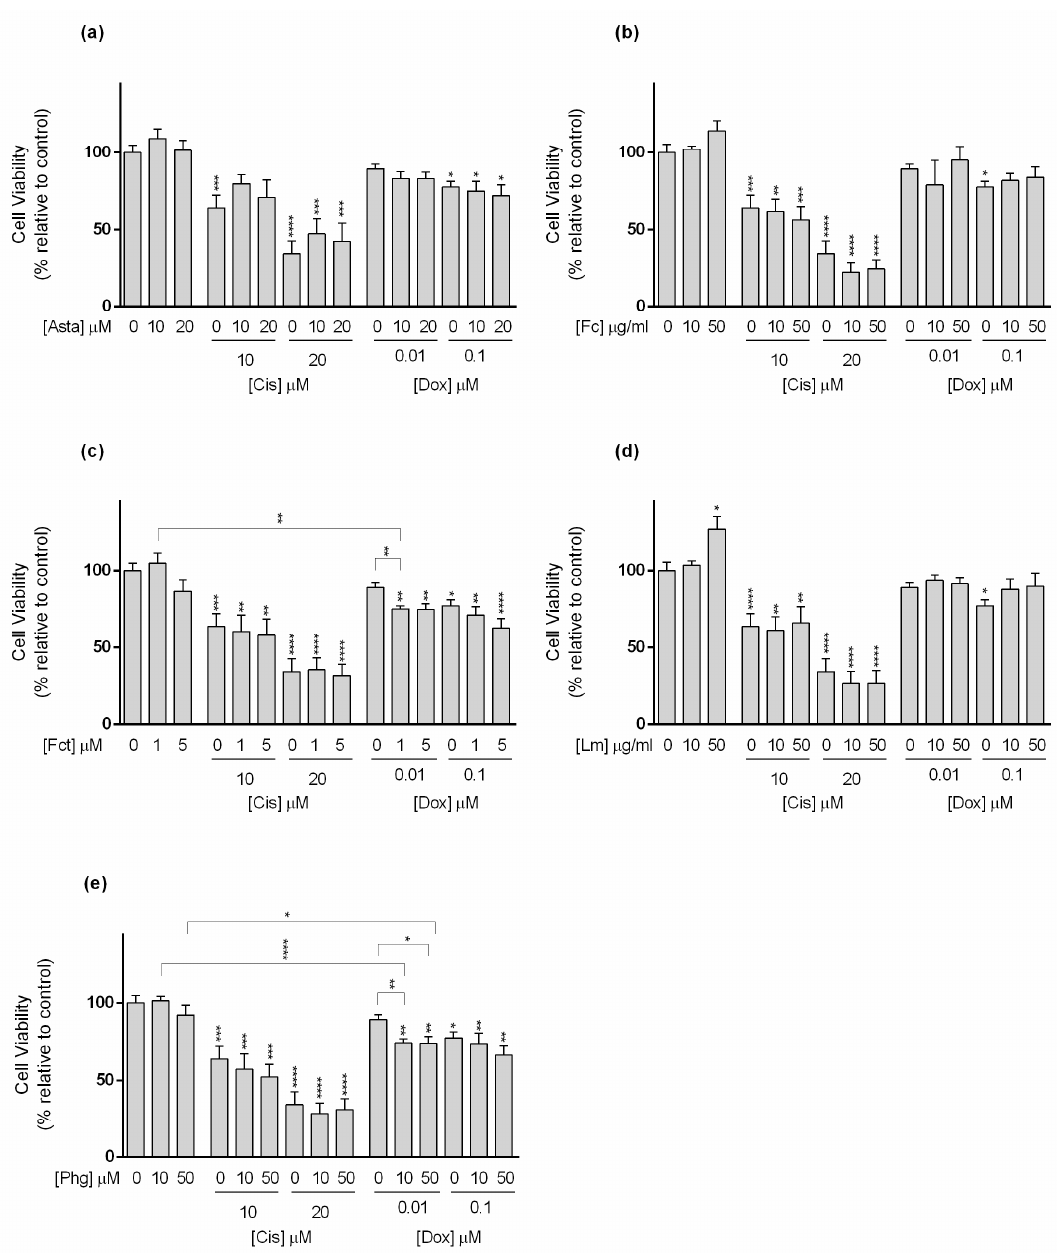
Figure 4. Cytotoxic effects of the combination of ( a ) Astaxanthin (Asta); ( b ) Fucoidan (Fc); ( c ) Fucosterol (Fct); ( d ) Laminarin (Lm); ( e ) Phloroglucinol (Phg) with the reference drugs cisplatin (Cis) and doxorubicin (Dox) assessed by the MTT assay after 72 h of exposure in MCF7 cell line cultured in monolayer. Control corresponds to cells incubated with medium containing 0.1% DMSO. The percentages of cell viability are relative to the control and presented as mean + standard deviation of six independent experiments (each in triplicate). Square brackets indicate t tests with Sequential Bonferroni corrections. (* p < 0.05, ** p < 0.01; *** p < 0.001, **** p < 0.0001).